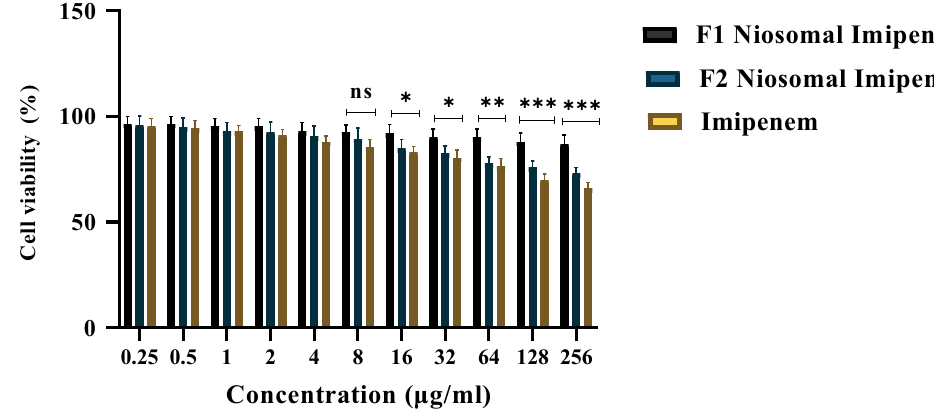
Figure 4. Cell viability percentage of HDF cells treated with various formulations of Niosome-encapsulated Imipenem in comparison with free Imipenem over 24 h (ns, p > 0.05, *** p < 0.001, ** p < 0.01, * p < 0.05. n =